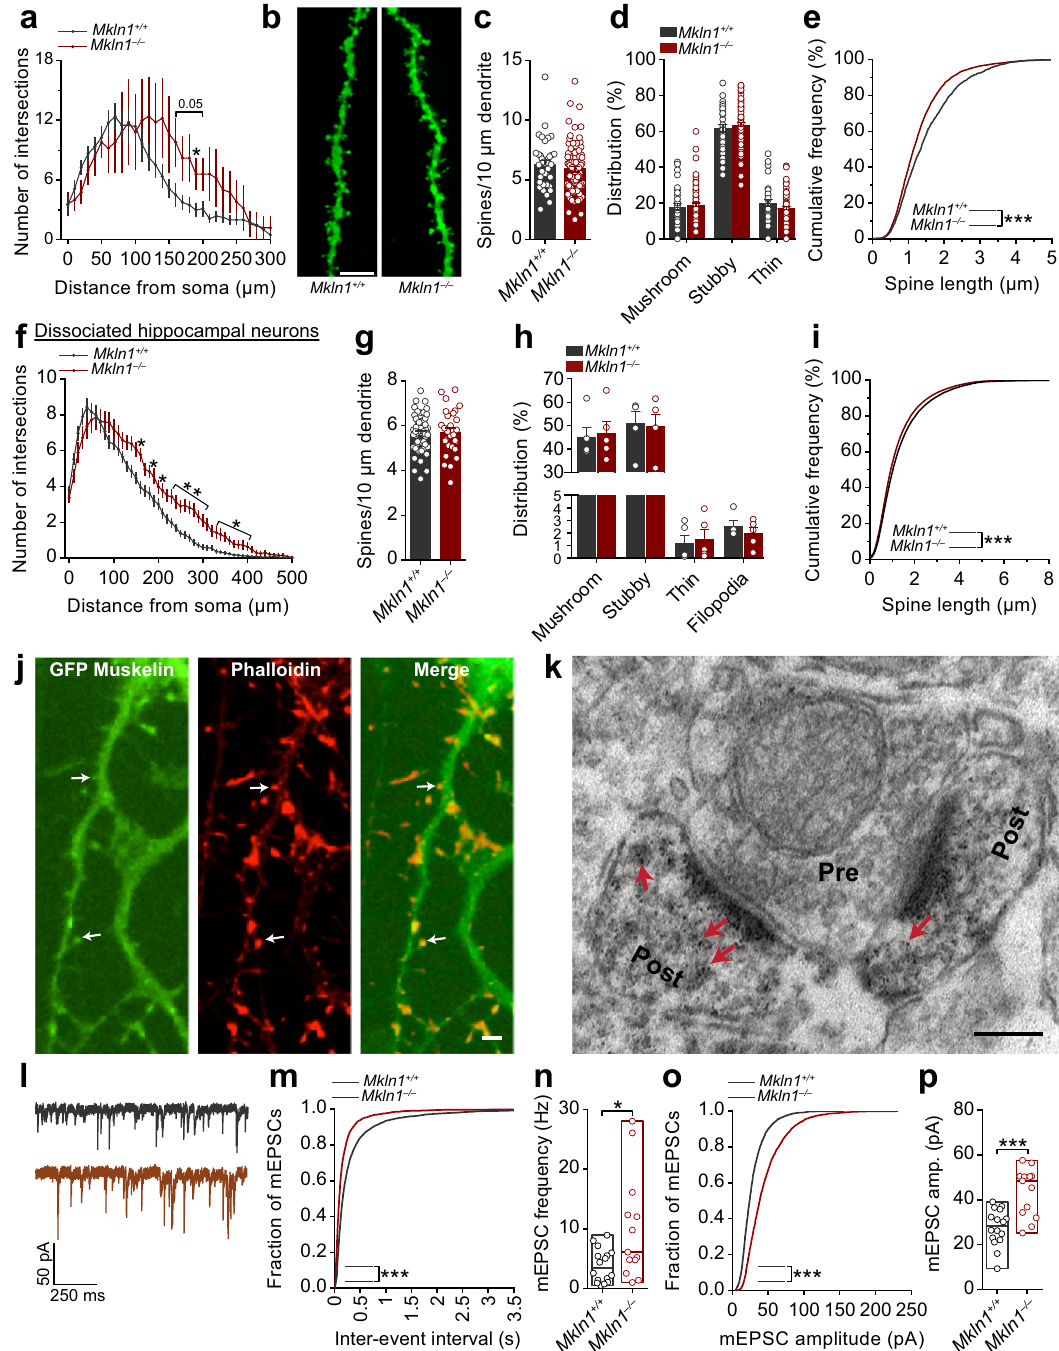
alterations in spine morphology prompted us to examine whether muskelin may be localized in excitatory synapses. Visualization of GFP-tagged muskelin in primary hippocampal neurons revealed muskelin distribution along dendritic shafts but also localization in a subset of actin-rich dendritic protrusions (Fig.